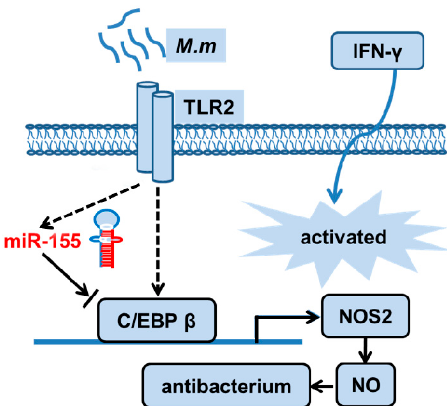
Figure 6. Schematic outline of miR-155-regulated bactericidal activity. miR-155 expression is induced by M.m in IFN- γ activated macrophages and mediates translational inhibition of C/EBP β by targeting its 3 ′ UTR. Successively, C/EBP β is induced and mediates NO-dependent antibacterial mechanism. Thereby, miR-155 can negatively regulate the NO-dependent antibacterial mechanism by C/EBP β . Black dash line arrow: direct effect; black solid line arrow: indirect effect; blue arrow: activated. C/EBP β was originally identified as a nuclear factor that regulates genes encoding acute phase proteins and cytokines in activated macrophages, such as IL-6, IL-1 α , TNF- α , and NOS2 [33,34]. Tanaka’s data show that macrophages from C/EBP β ( − / − ) mice have defects in, not only the killing of intracellular pathogens, but also in tumor killing [40]. Consequently, C/EBP β ( − / − ) mice are